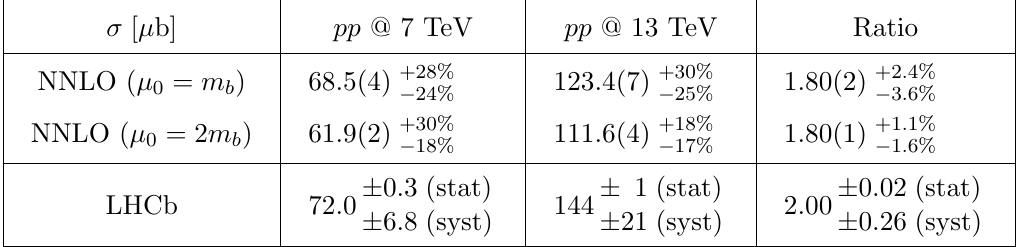
Table 4 . Cross section for single-inclusive b -quark production at p s = 7 and 13 TeV in the pseudorapidity region 2 < (cid:17) b < 5. The NNLO results are compared with the LHCb measurement av of Ref. [20]. Numerical errors on the last digits are stated in brackets, as in Table 1. The LHCb data are presented with their statistical and systematic